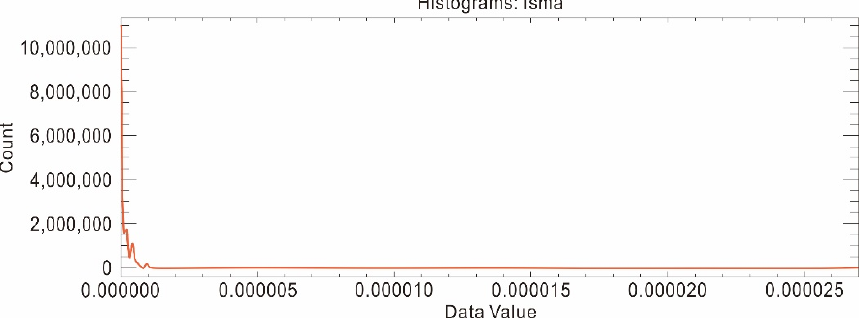
Figure 9. RMSE Histogram for spectral decomposition: the RMSE value of most pixels is close to 0, which is much less than 0.02, meeting the decomposition requirements.